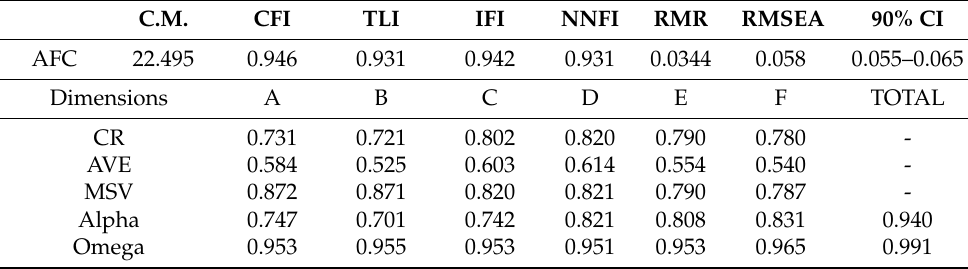
Table 3. Construct, discriminant and convergent validity and reliability of the